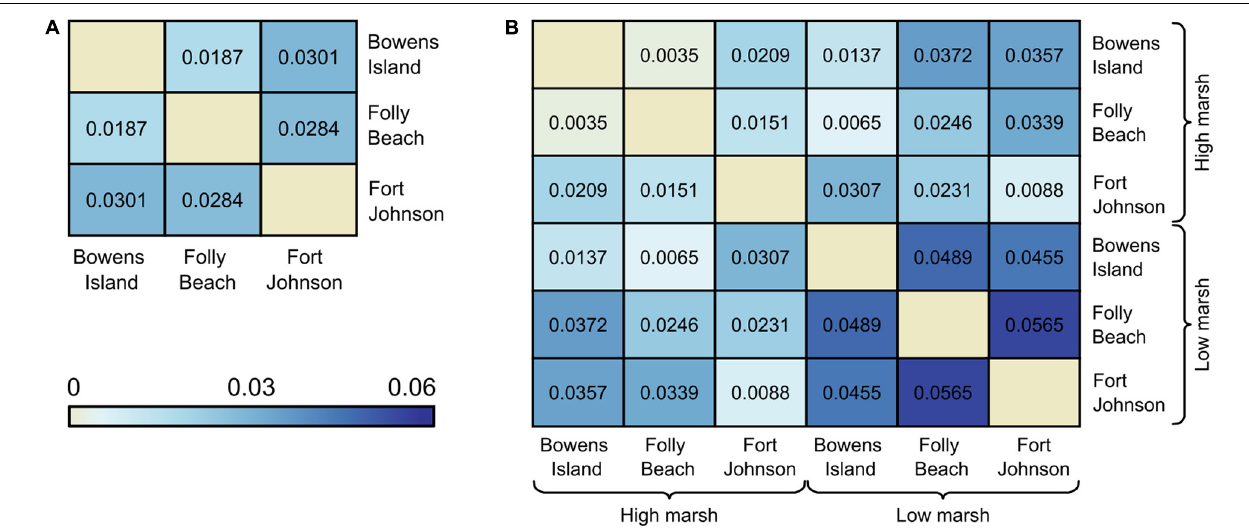
Frontiers in Ecology and Evolution |